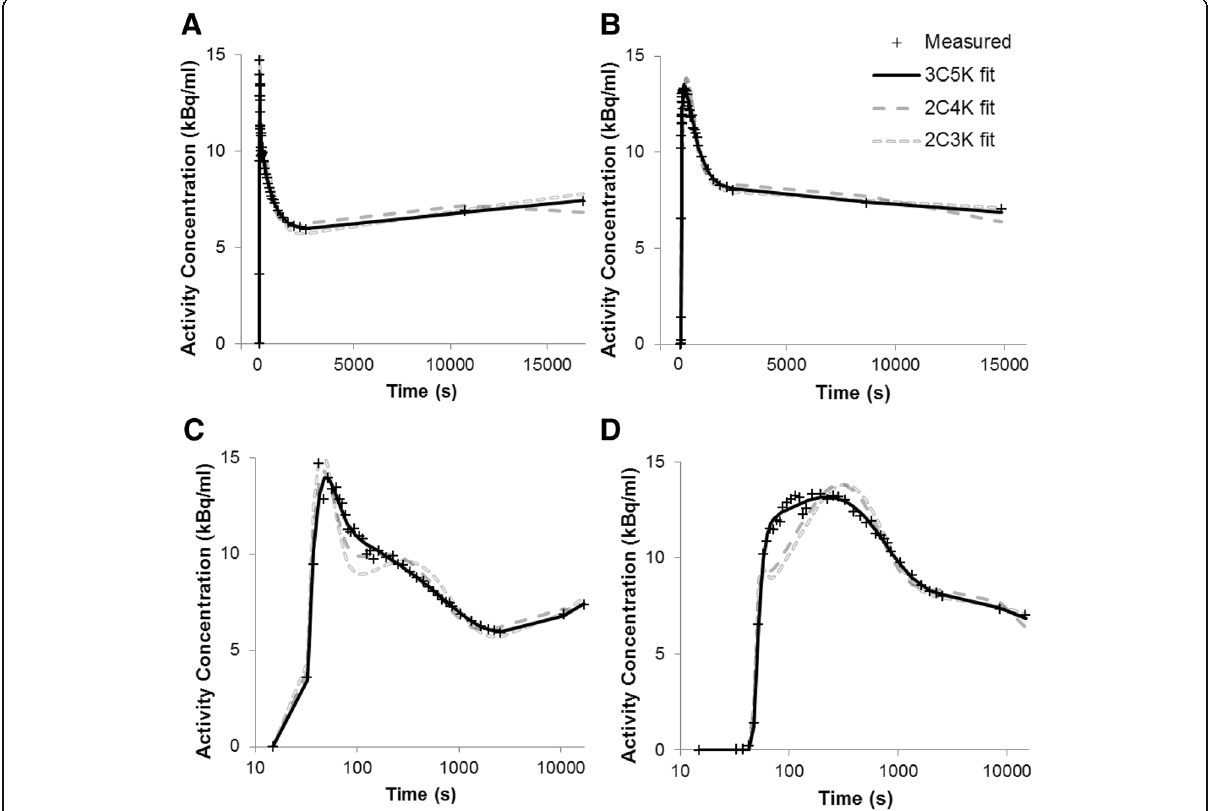
Fig. 5 Fits of the 2C3K, 2C4K, and 3C5K models to FMISO TACs 4 (plots a and c ) and 24 ( b and d ). Time post-injection is plotted on linear ( a / b ) and logarithmic ( c / d ) scales to enable the early part of the TAC and modeled TAC to be